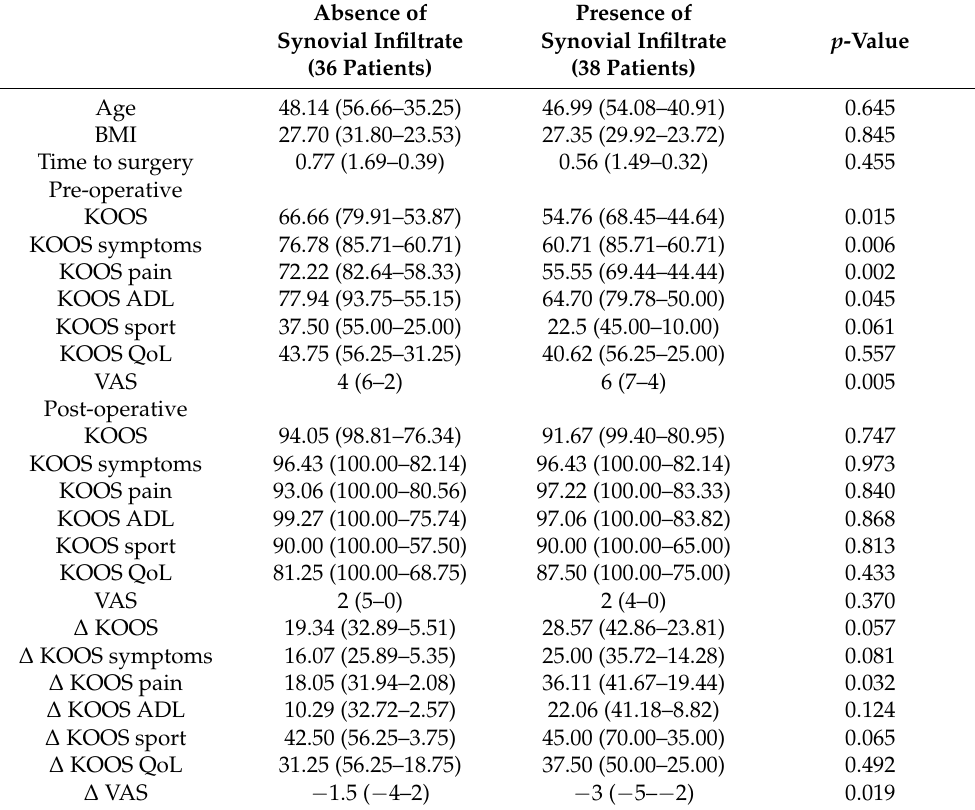
Table 1. Demographic and clinical outcomes of patients with/without synovial mononuclear cell infiltration.